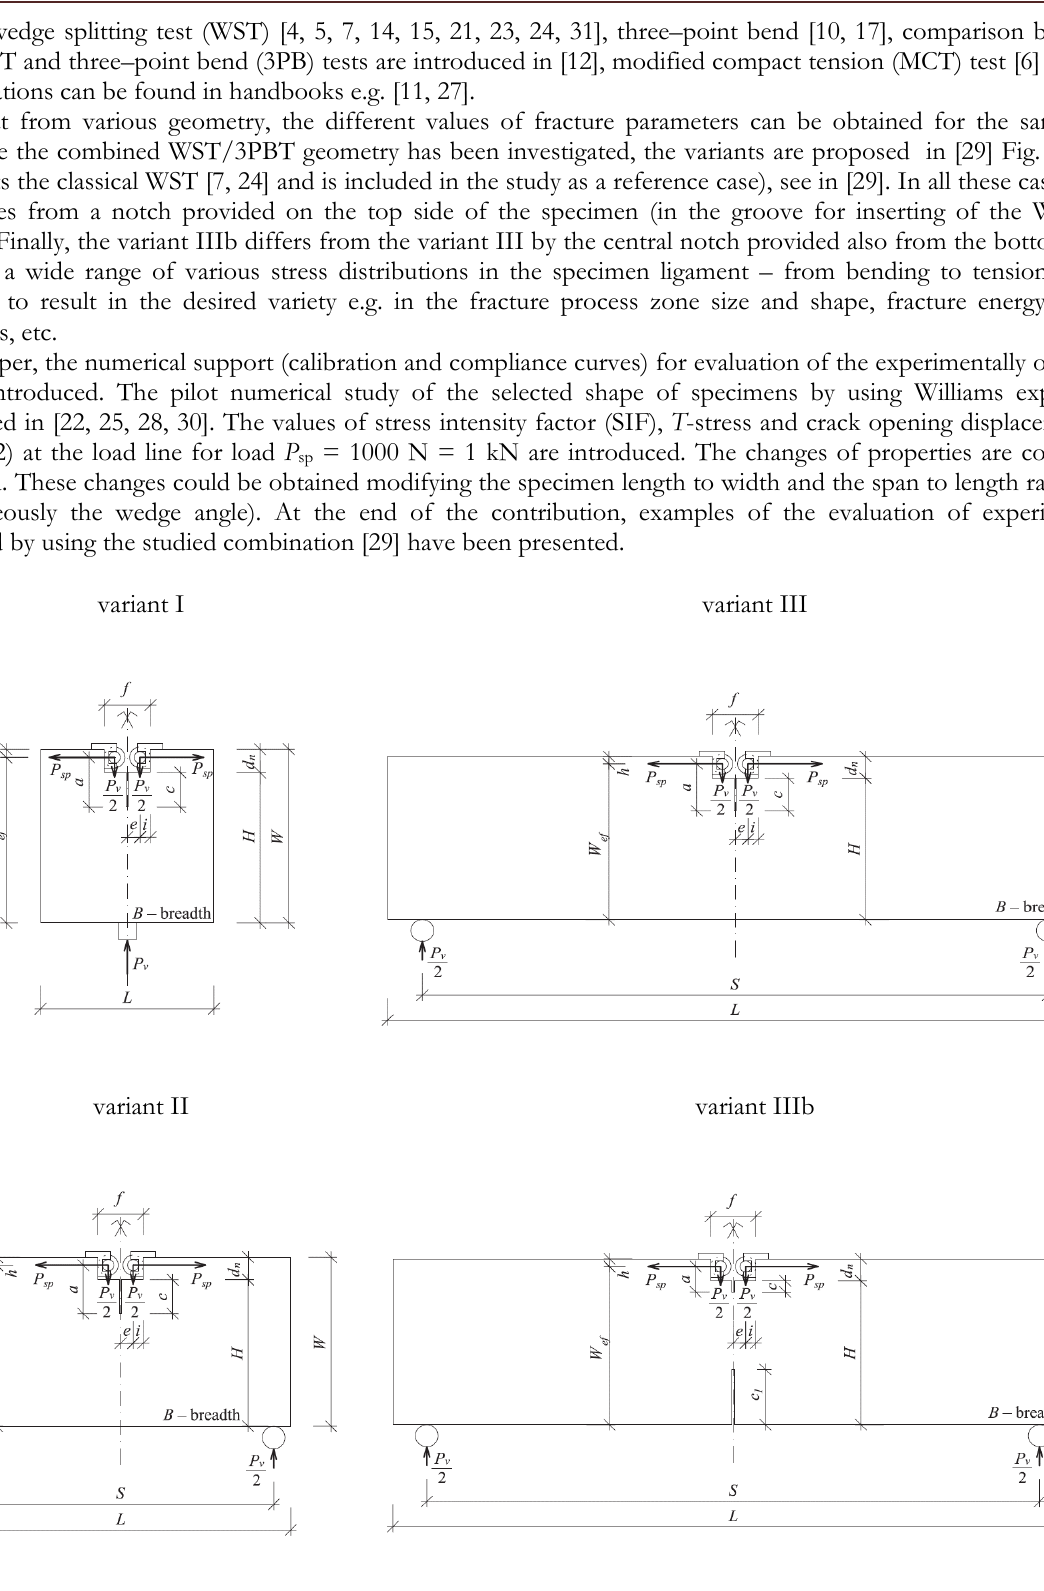
Figure 1: Considered variants for the combined bending/splitting configurations, taken from